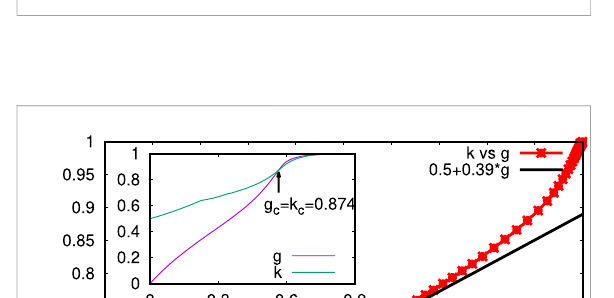
FIGURE 3 Steady state money distribution ρ ( m ) for fi xed saving propensity λ in the kinetic exchange model where in each two- body scattering (trade), one particle (trader) is with least energy (money), andtheotheroneischosenrandomlyfromtherest. Intheinset,thevariationsofinequalityindices k and g andlocation of the self-organized minimum energy (poverty) level (SOPL) are shown against fi xed saving propensity λ . Adapted from [14].